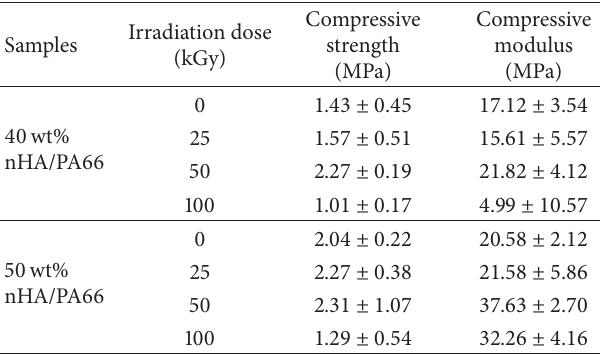
Table 1: Compressive strength and modulus of irradiated and nonirradiated scaffolds.